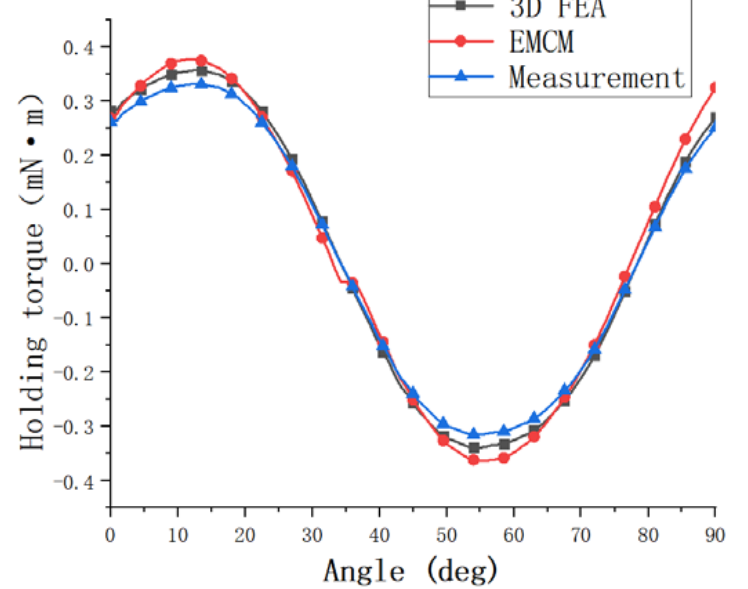
Figure 8. Holding Torque Comparison Chart.